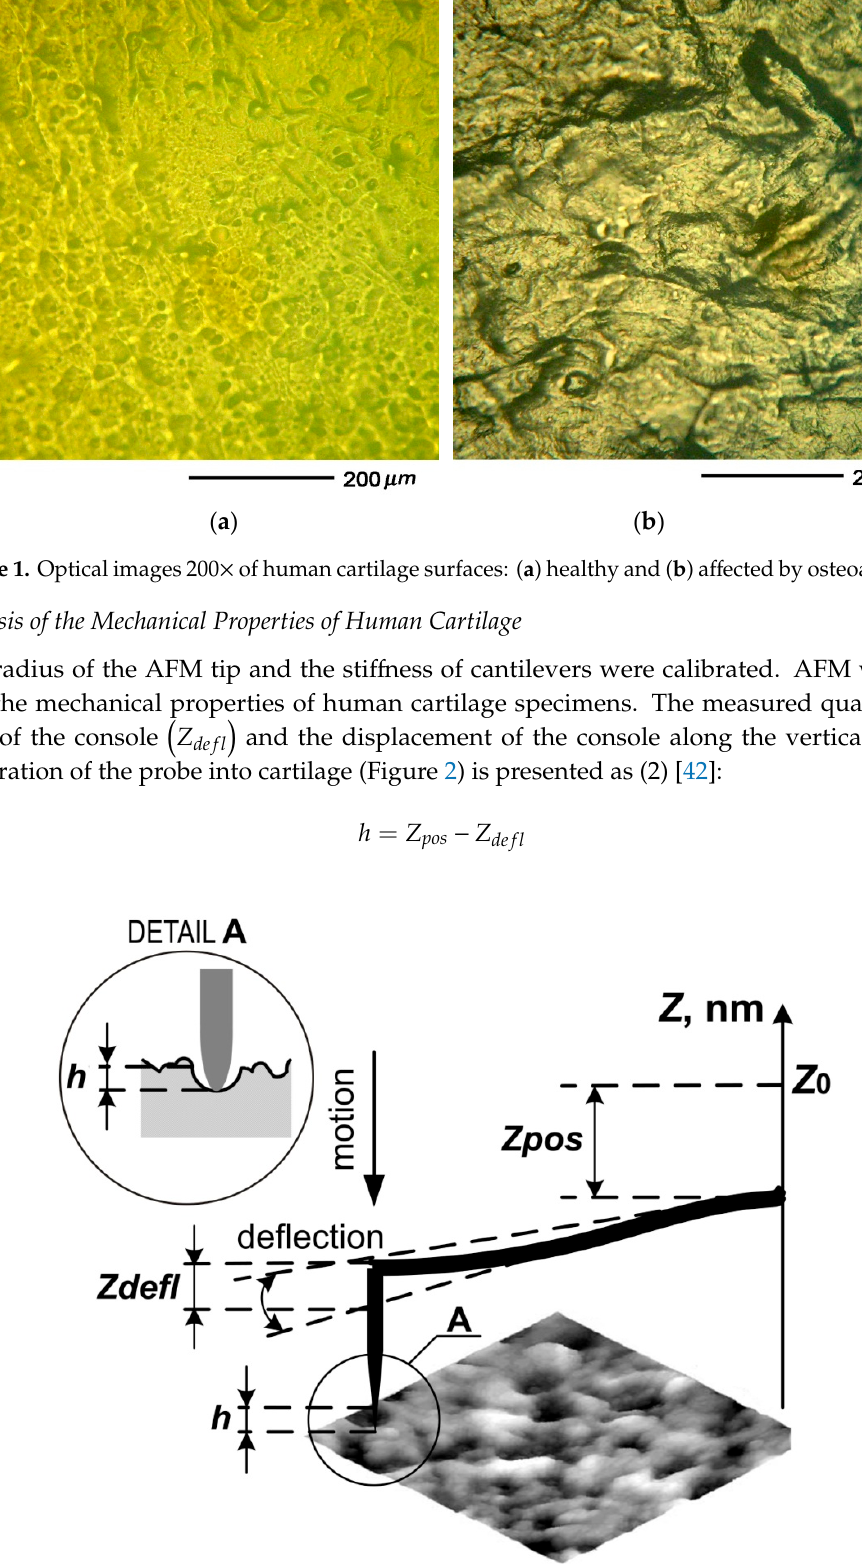
Figure 2. Scheme of AFM indentation: Z 0 − the starting point of the console; Z defl − the bend of the console ; Z pos − the displacement of the console along the vertical axis; h - the penetration of the probe into cartilage.